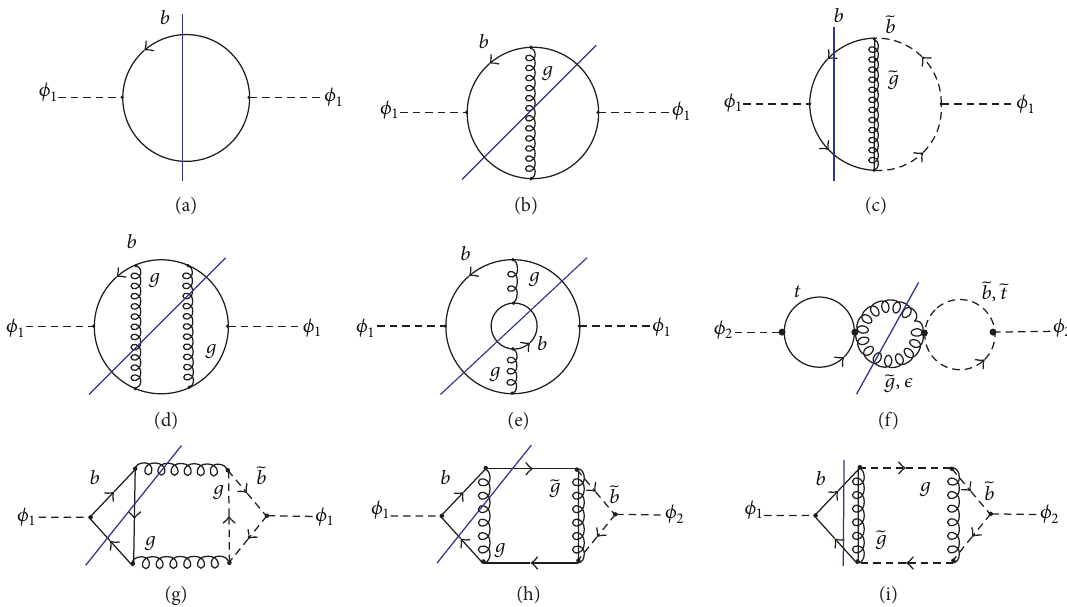
Figure 20: One-, two-, and three-loop Feynman diagrams contributing to the Higgs boson propagator in SUSY-QCD. Dashed lines denote Higgs bosons, whereas oriented dashed lines represent the squarks. For the other particles we use the same convention as before.